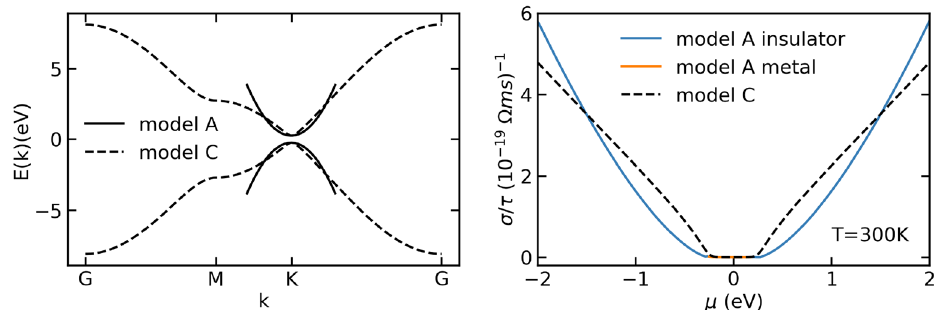
Figure 2. Band-structure of a graphene model and parabolic fit at K (left panel, dashed and solid line, respectively). The right panel shows the corresponding conductivities computed with Eqs. (14), (17), and PAOFLOW.